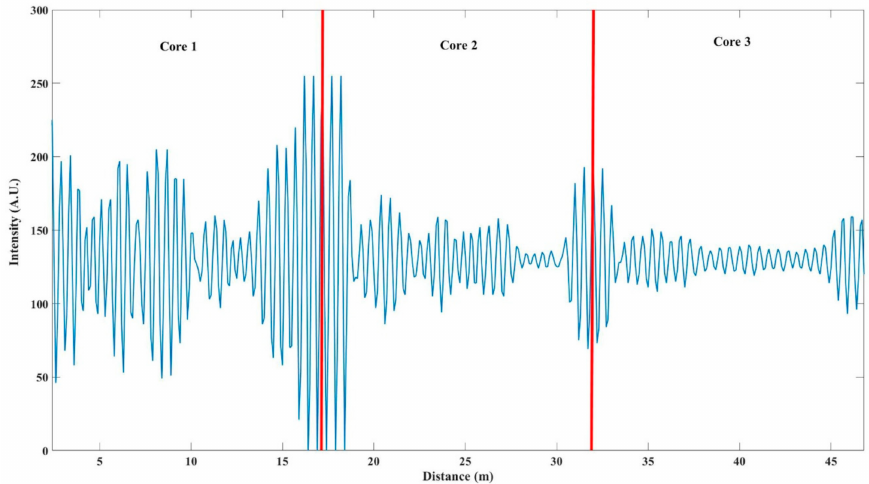
Figure 9. Intermediate frequency (IF) signal intensity of three